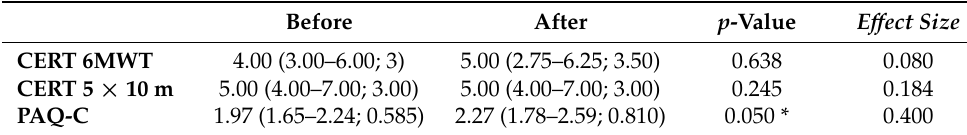
Table 4. CERT and PAQ-C scores before and after the training program. Before After p -Value Effect Size CERT